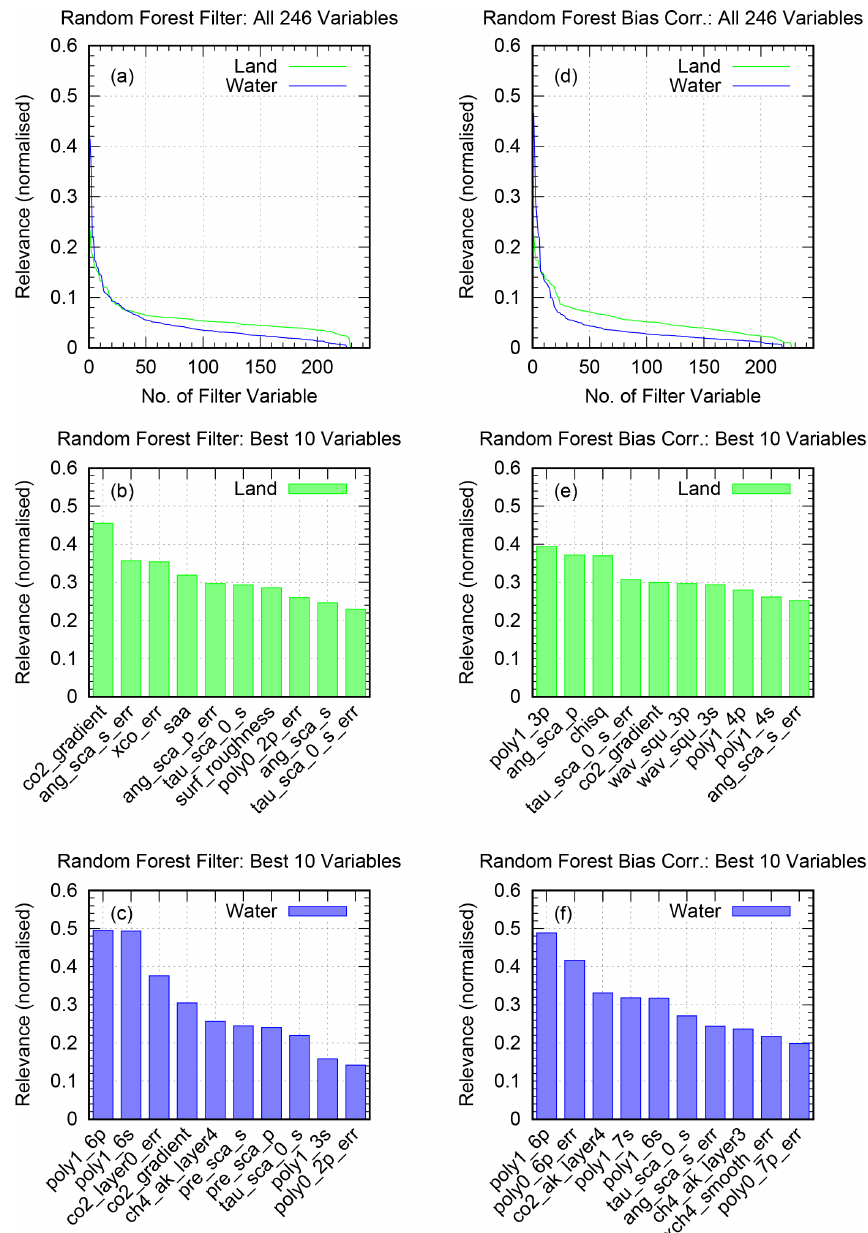
Figure 6. As Fig. 5, but for GOSAT-2.